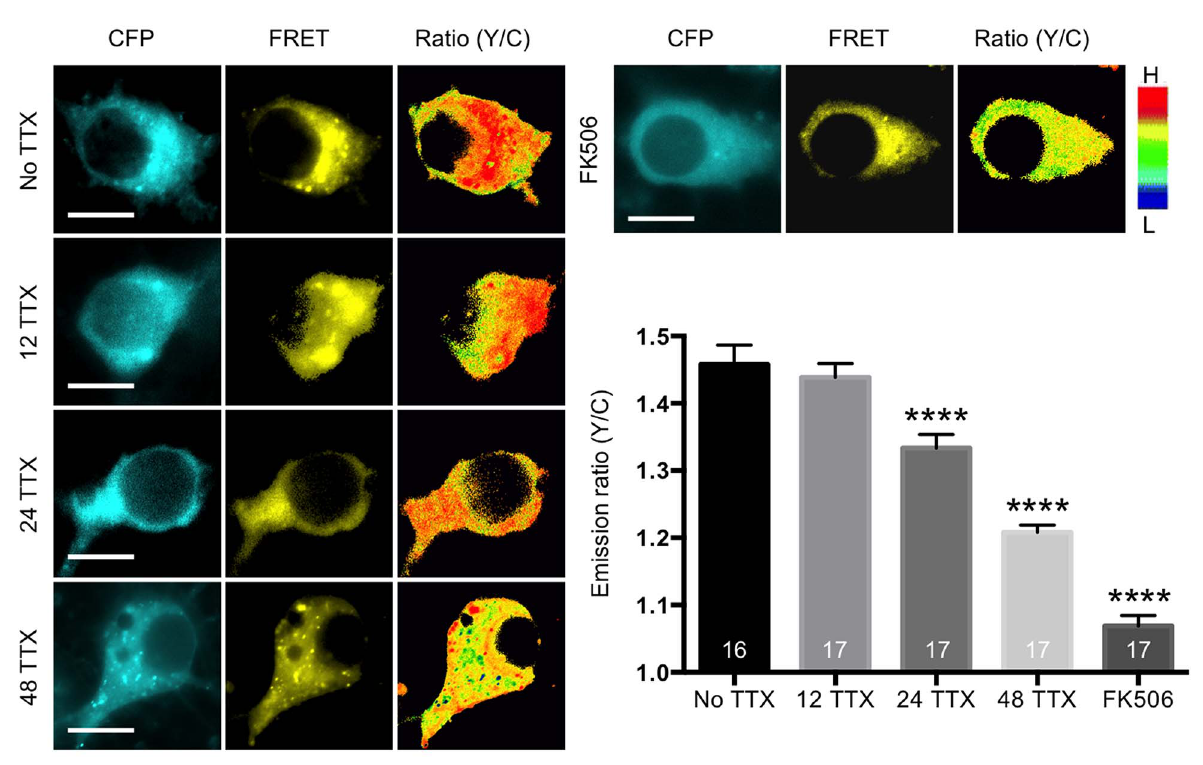
Figure 3. TTX reduced invivo calcineurin activity in a time-dependent manner. Representative images of CFP channel, FRET channel, and pseudocolored emission ratio (Y/C) in each condition [blue (L), low emission ratio; red (H), high emission ratio]. Scale bar is 10 m m. A summary graph showing average of emission ratio (Y/C) in each condition ( n =number of cells) (**** p , .0001, one-way ANOVA, uncorrected Fisher’s LSD).